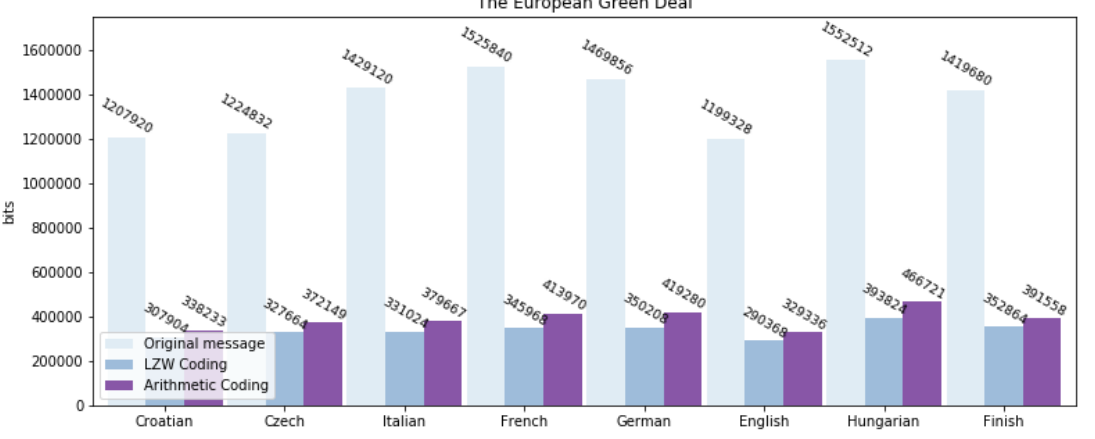
Figure 6. Encoding The European Green Deal.